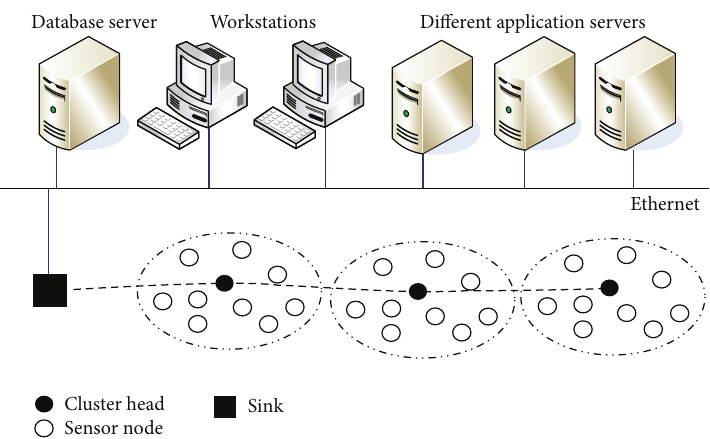
Figure 1: Multiapplication system architecture of wireless sensor